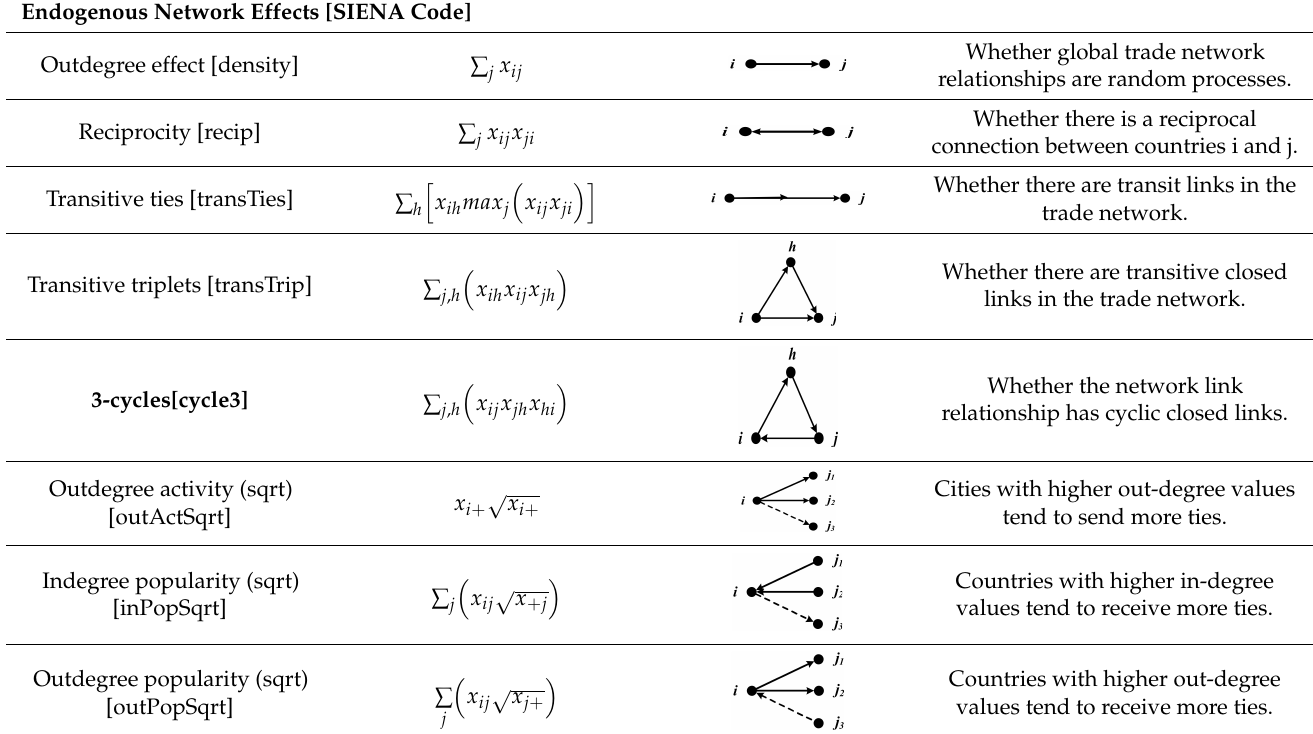
Table 2. Network effects in